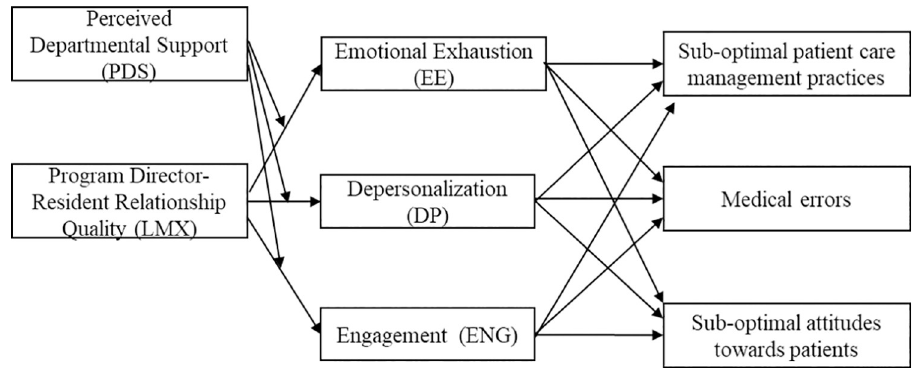
Fig 1. Conceptual framework for the